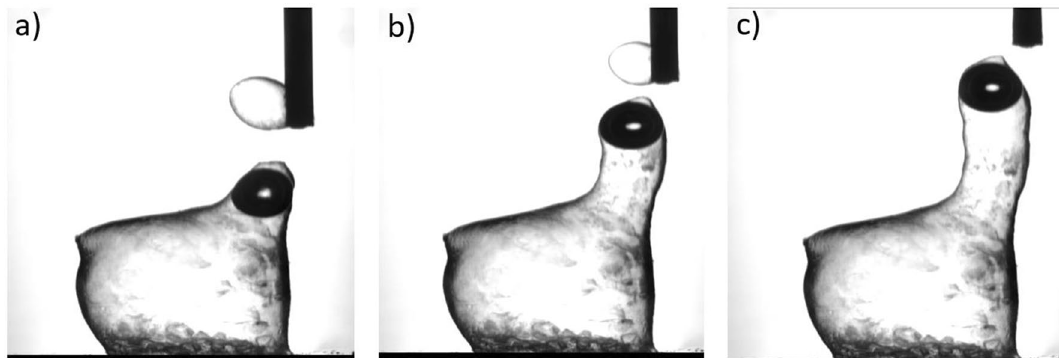
Figure 11. Self-healing of 3D printed objects. Optical images of the formation of tubular structure after self- healing. ( a ) A nozzle with a 3D printed object is approaching a 3D printed structure on the substrate. The dark spot is the air bubble inside the object. ( b ) Hexane solution is injected when these to objects are in contact. ( c ) When these to objects are merged due to the self-healing mechanism the nozzle is moved vertically up